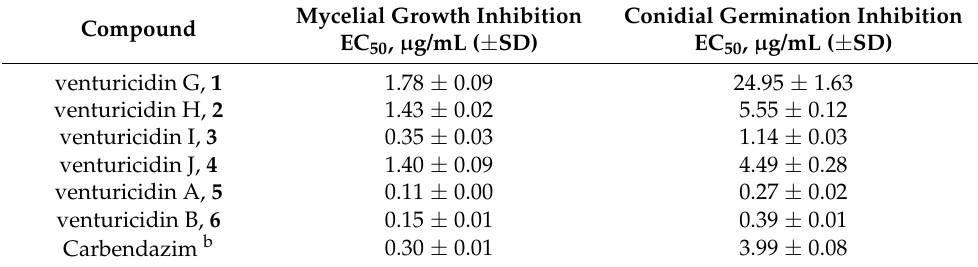
Table 3. Half maximal effective concentration (EC 50 ) values of Compounds 1–6 on P. oryzae a